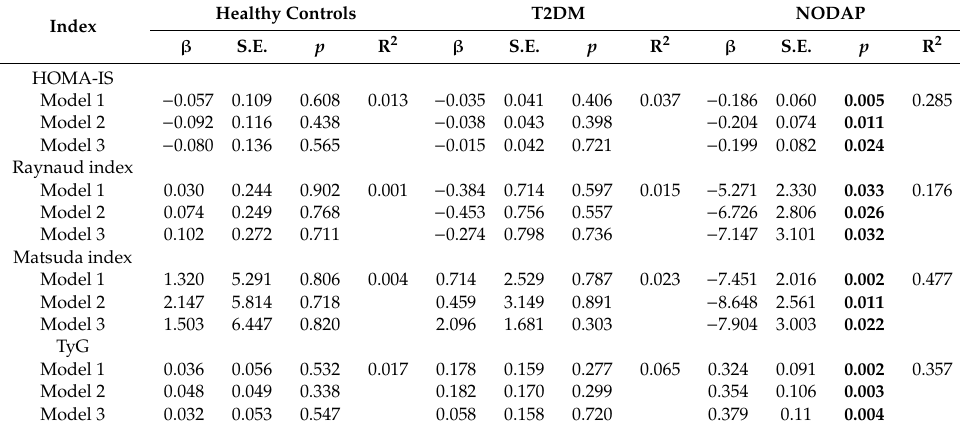
Table 2. Associations between intra-pancreatic fat deposition and indices of insulin sensitivity in non-obese